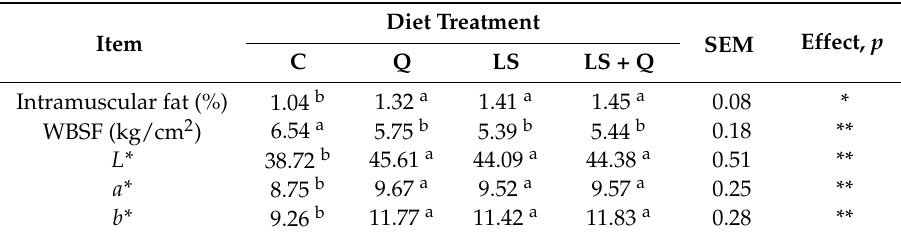
Table 4. Intramuscular fat content, Warner–Bratzler shear force (WBSF) and color parameters (lightness: L*, redness: a*, yellowness: b*) of quadriceps femoris from lambs as affected by different diet